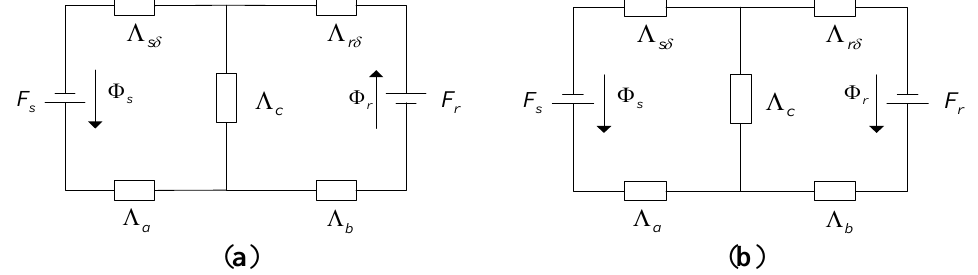
Figure 4. Simplified equivalent magnetic circuits diagrams of SRDRM: ( a ) MMF directions of stator and rotor windings are the same; ( b ) MMF directions of stator and rotor windings are